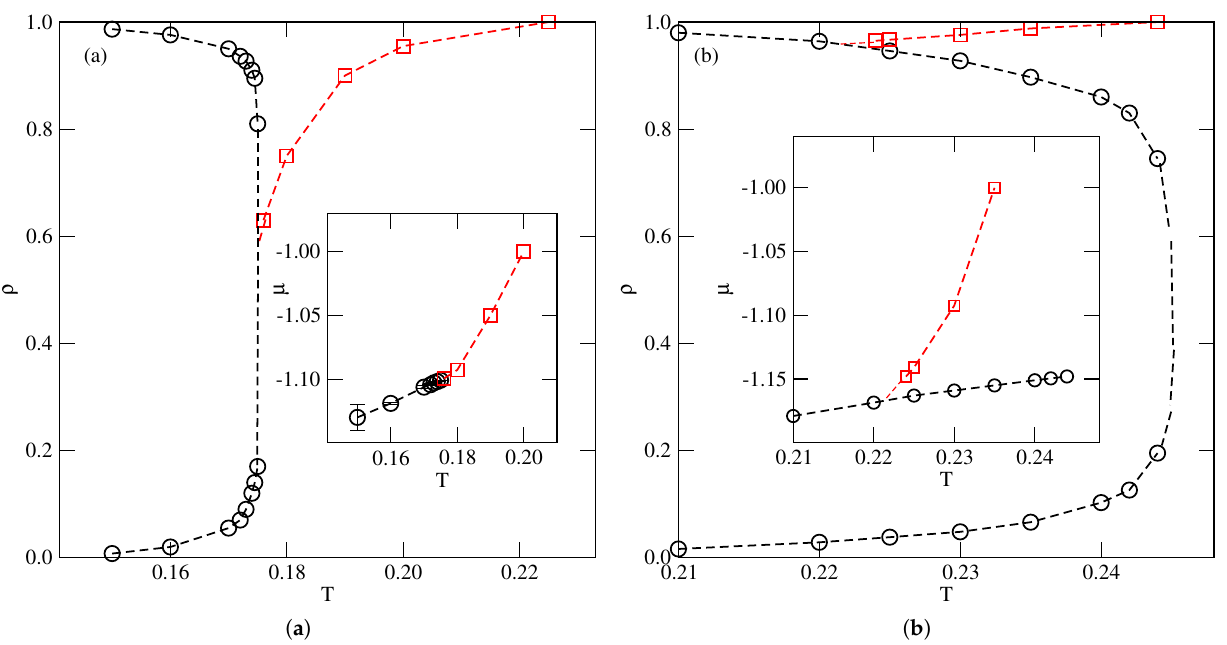
Figure 13. The estimated phase diagrams for the systems with u AB = 0 and u bB equal to − 0.10 ( a ) and − 0.2 ( b ). The main panels and insets show the T − ρ and the T − µ projections, respectively. The circles and squares mark coexistence points of first − order and continuous transitions,